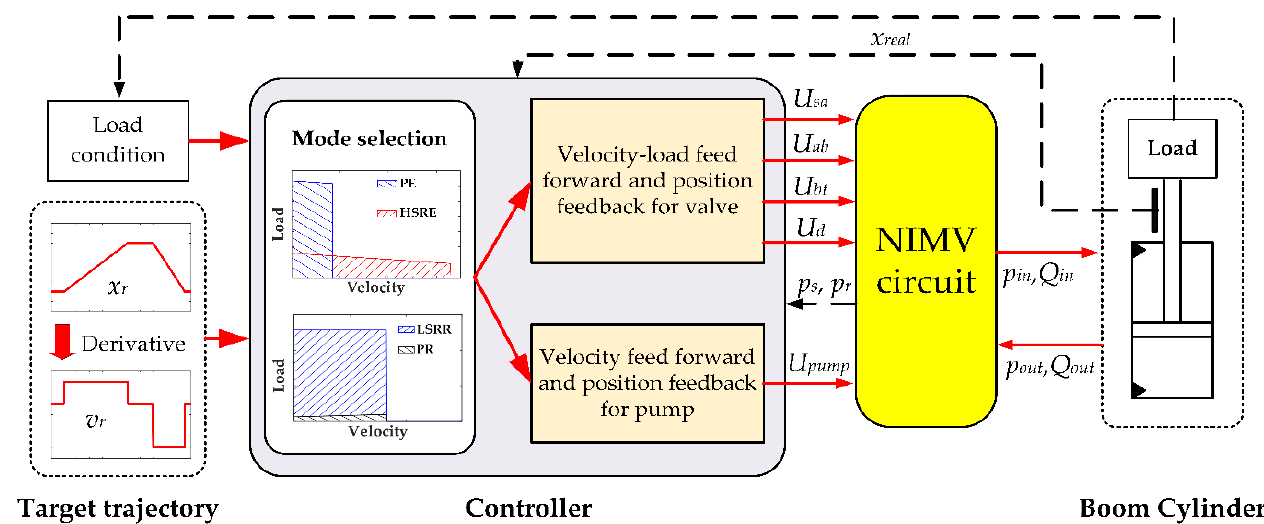
Figure 10. Overall control strategy of the NIMV system for the boom excavator.